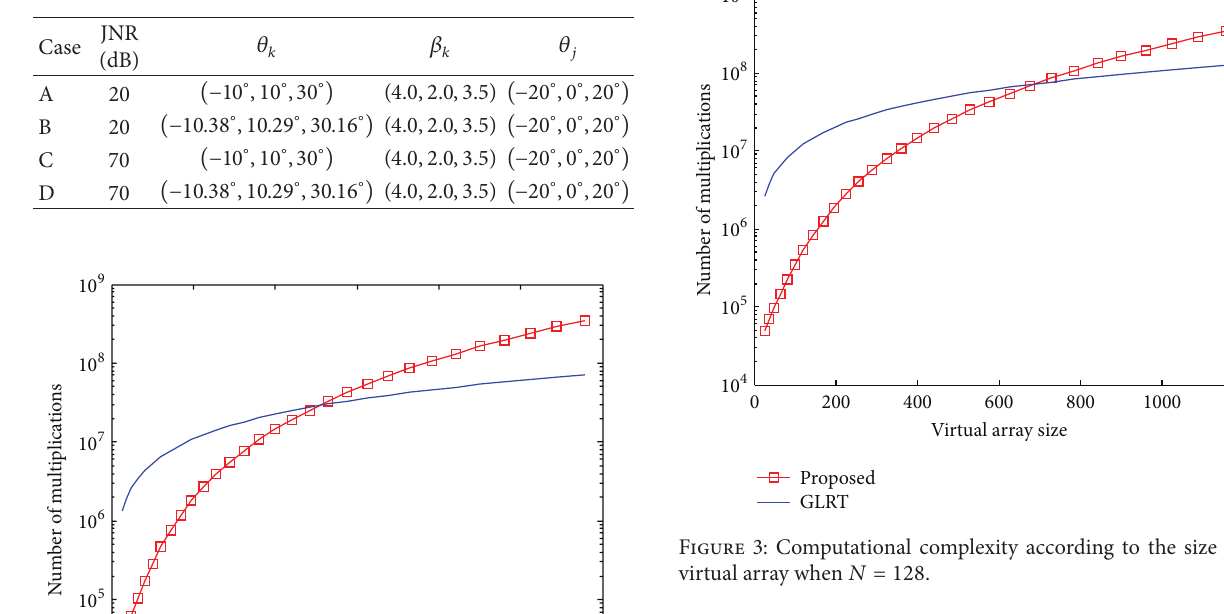
Table 1: Simulation conditions.